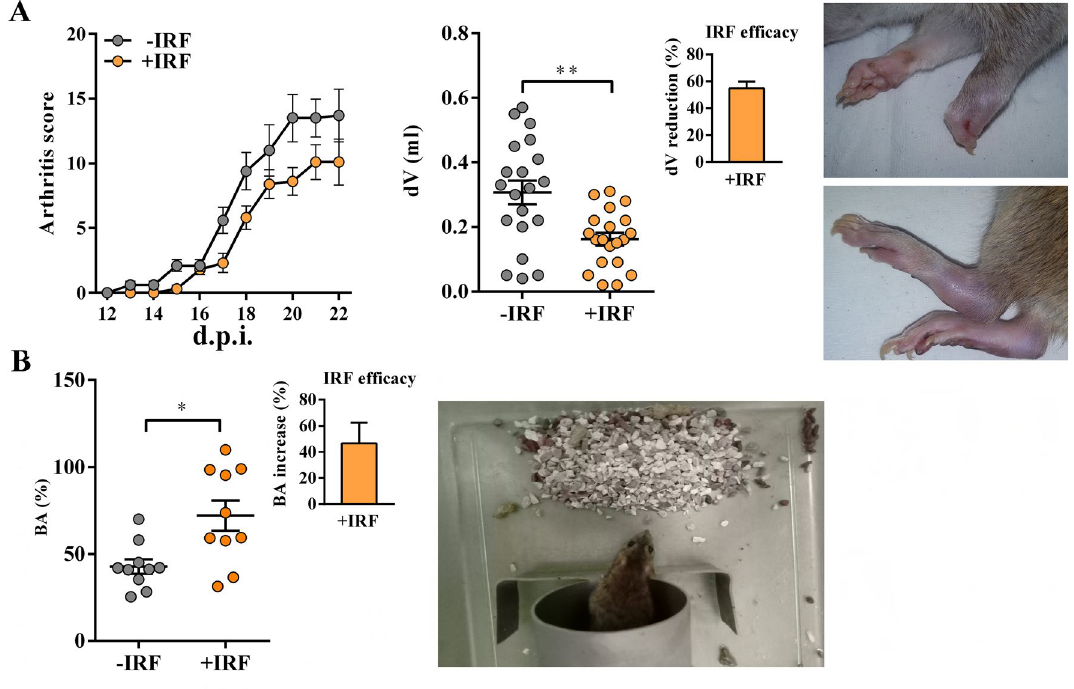
Figure 1. Influence of exposure to IR fibres on daily arthritis score, paw edema and burrowing behaviour in CIA-affected rats. (A) Line graph shows daily arthritis score from the 12th–22nd day post-immunisation (d.p.i.) in CIA rats housed in cages with IR-fibre bedding (+IRF rats) or in cages with standard wooden shaving bedding (−IRF rats). Of note, rats were transferred to cages with IR fibre bedding five days before immunization. Scatter plot indicates CIA-induced increase in hind paw volume (dV) in +IRF and −IRF rats. Bar graph shows the dV reduction (%) in +IRF rats relative to −IRF rats (see Material and Methods). Photographs show representative arthritic front and hind paw joints from rat with CIA. (B) Scatter plot indicates the burrowing activity (BA) of each +IRF and −IRF rat expressed as the percentage of the BA before immunisation (basal activity). Bar graph shows the increase in BA (%) in +IRF rats relative to −IRF rats (see Material and Methods). All graphs were created using GraphPad Prism version 7.00 for Windows, GraphPad Software, La Jolla, California, USA (https ://www.graph pad.com). Photograph shows a cage-burrow setup and burrowed gravel. Results are expressed as mean ± SEM. n = 10 rats/group. * p ≤ 0.05 and ** p ≤